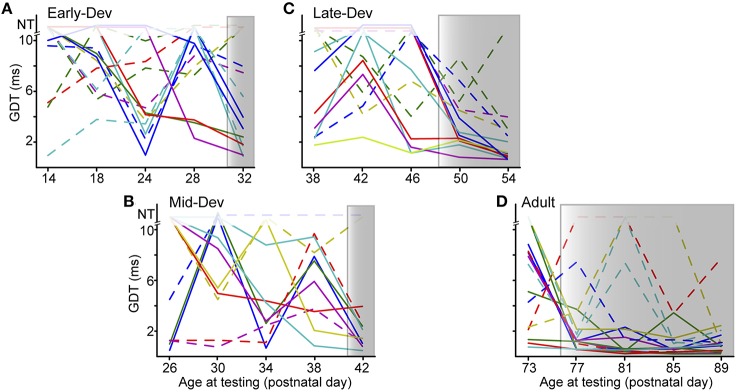
The ability to improve with gap-PPI experience has its own developmental trajectory. (A–D) Panels for each age group show individual trajectories of GDTs across sessions, arranged to depict sessions with overlapping ages across groups. Shaded regions are those sessions with significantly better GDTs compared with session 1. Solid lines are those animals showing trajectories of improvement, while dashed lines are those animals with more variable GDTs across sessions. The data displayed for ED is for a subset of the animals in that group (ED4) but the analysis was performed on data from all ED animals. NT = no threshold, indicating that the longest gap presented (10 ms) was not detected.